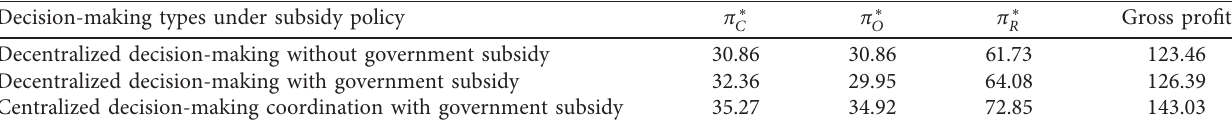
Table 2: Comparison of profits of members in supply chain in various conditions.